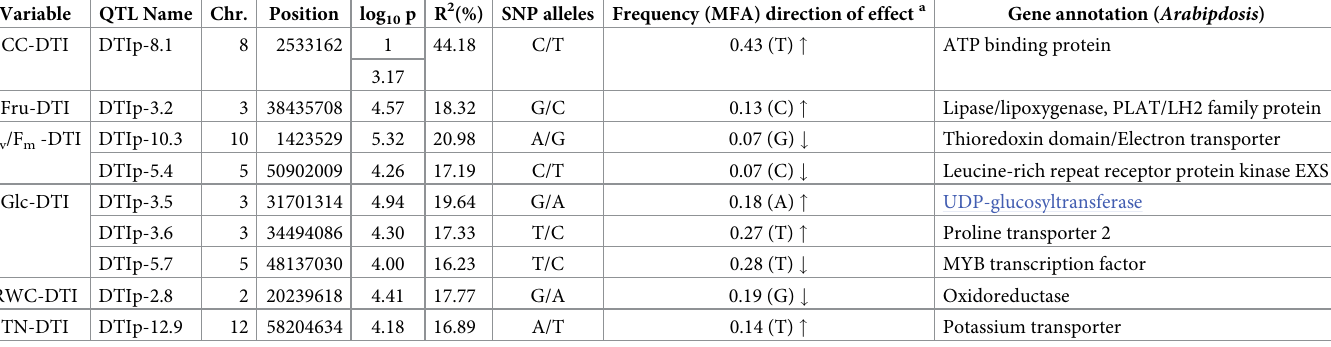
Table 2. Summary of genome associations for drought stress index (DTI) in a diversity panel of 104 accessions of Solanum tuberosum group phureja. Variable, QTL name, chromosome (Chr), position, its significance, phenotypic variance explains by QTL (R 2 (%)), SNP alleles, frequency (MFA) direction of effect and gene annotation where the QTL map.